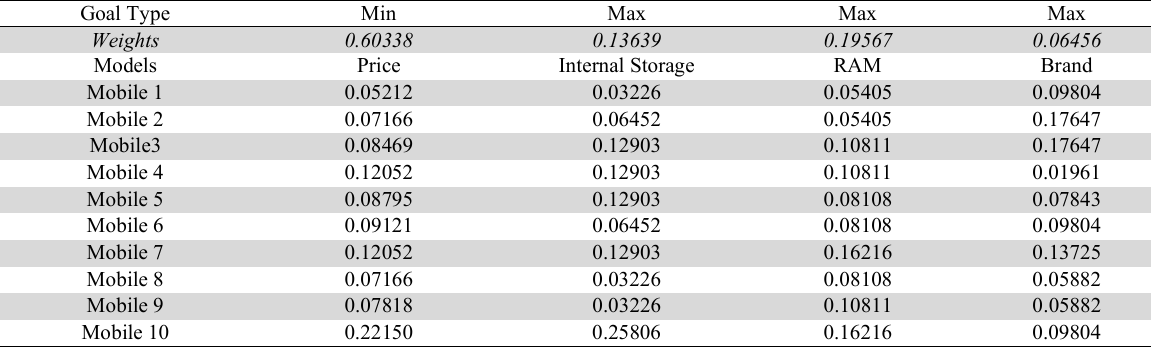
Normalization of the Decision Matrix